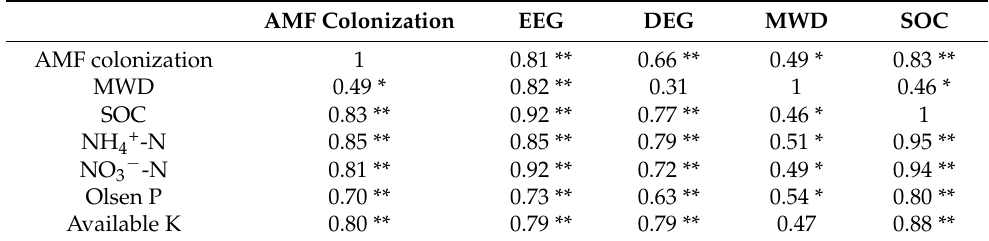
Table 4. The correlation between AMF colonization and soil properties ( n =